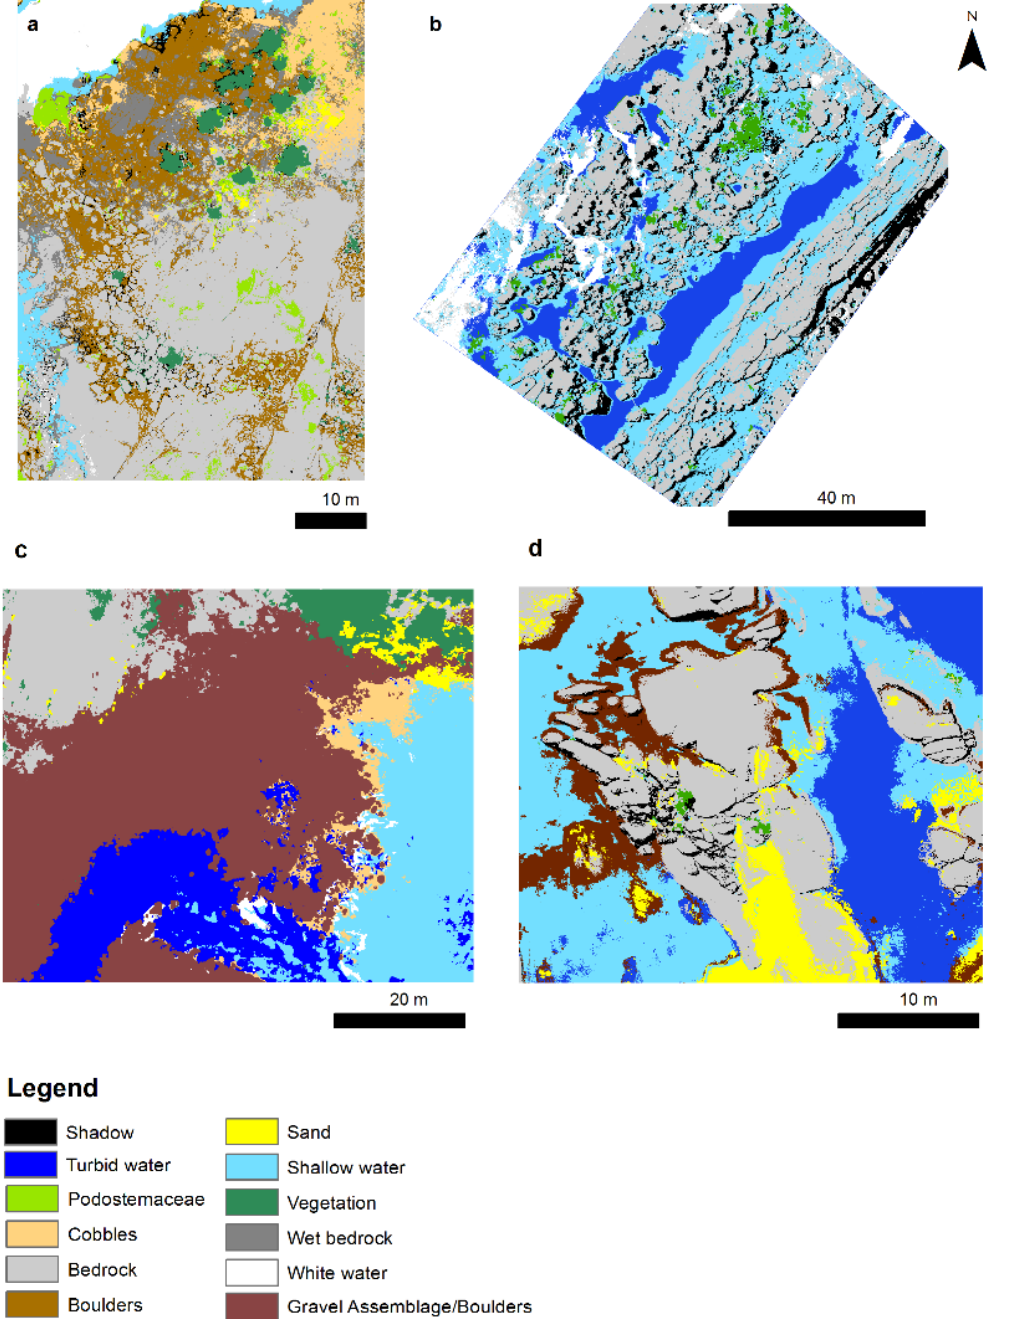
Figure 13. Map of substrate classes from the UAV SfM-MVS products and neural network classification for ( a ) Iriri; ( b ) Culuene; ( c ) Xadá and ( d ) Retroculus.